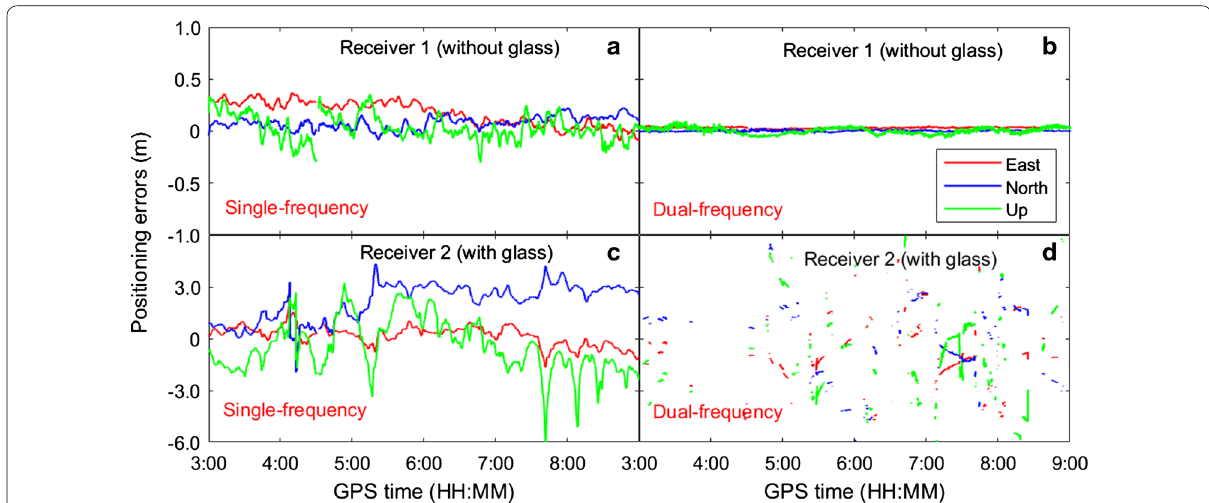
Fig. 7 GPS/GLONASS single and dual-frequency kinematic positioning results for the two receivers during period